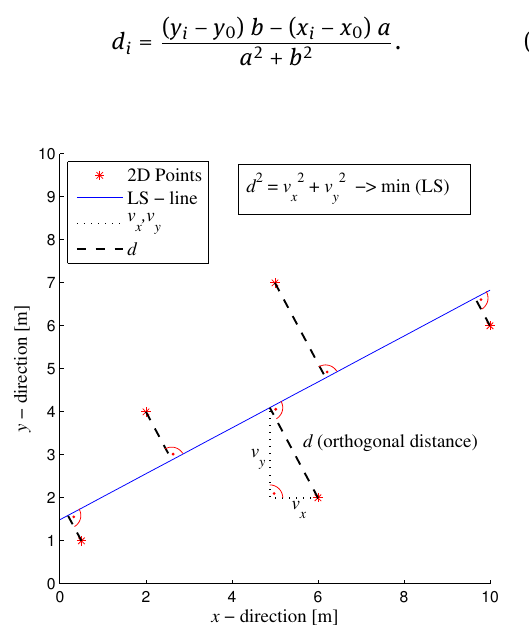
Figure 2: Example of fitting a straight line to 2D points with both x and y coordinates subject to measurement